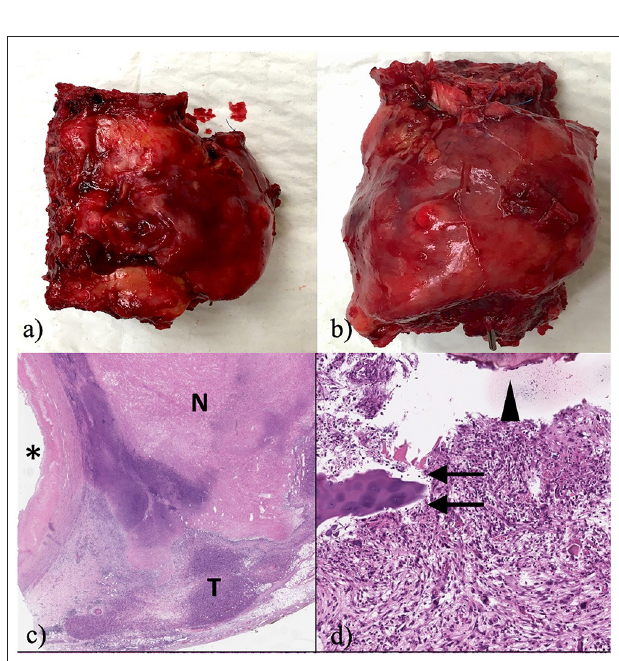
FIGURE 4 | (a) Macroscopic lateral view of the resected tumor; (b) Macroscopic front view of the resected tumor; (c) at scanning magnification of a diffusely necrotic neoplasm infiltrates the adventitia of the aorta (aortic lumen marked by the asterisk; T: indicates the viable tumor; N: indicates the necrotic component; original magnification (OM) 10x; staining: haematoxylin and eosin (H&E); (d) depicts bone (arrowhead), cartilage (arrows) and the variable shape and size of the nuclei of pleomorphic soft tissue sarcoma (100x; staining: H&E).